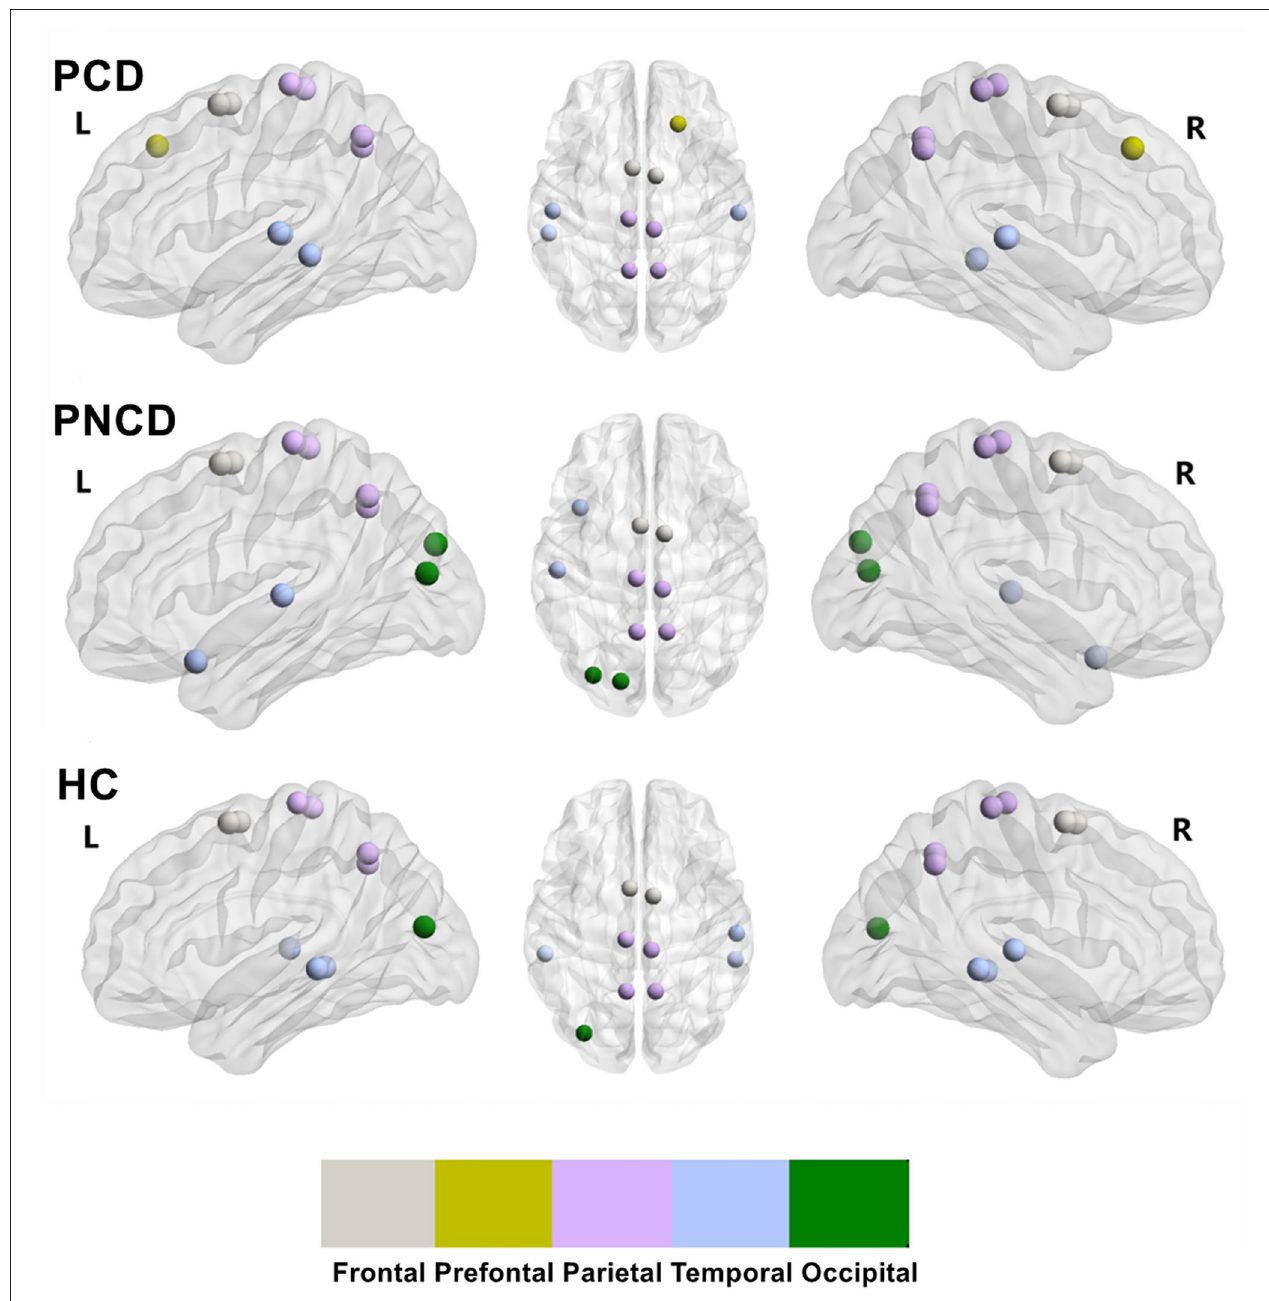
FIGURE 4 | The rich-club organization for presbycusis patients with cognitive decline, presbycusis patients without cognitive decline, and healthy controls. PCD, presbycusis patients with cognitive decline; PNCD, presbycusis patients with no cognitive decline; HC, healthy controls. The distribution of rich-club nodes in the whole brain for each